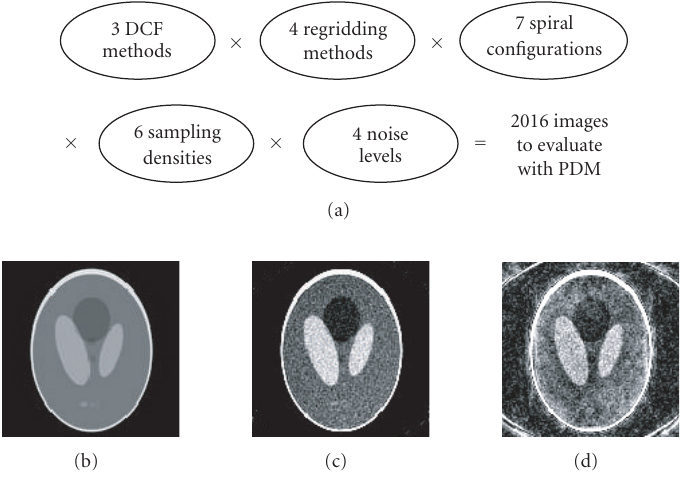
Figure 2: Many images of varying quality were systematically evaluated with PDM. We evaluated the 2016 conditions identified in (a). The original, or reference, image is shown in (b), with a PDM score of 0. The image in (c) was acquired with 21 interleaves, 100% sampling density, noise level = 3, and reconstructed with Voronoi and conventional regridding. This is an example of good image quality for a noisy image, giving a PDM score of 14 . 34. With 5 interleaves, 80% sampling density, noise level = 3, a reconstruction with ADF and MXR 2X gives particularly poor image quality (d) with a PDM score of 21 .